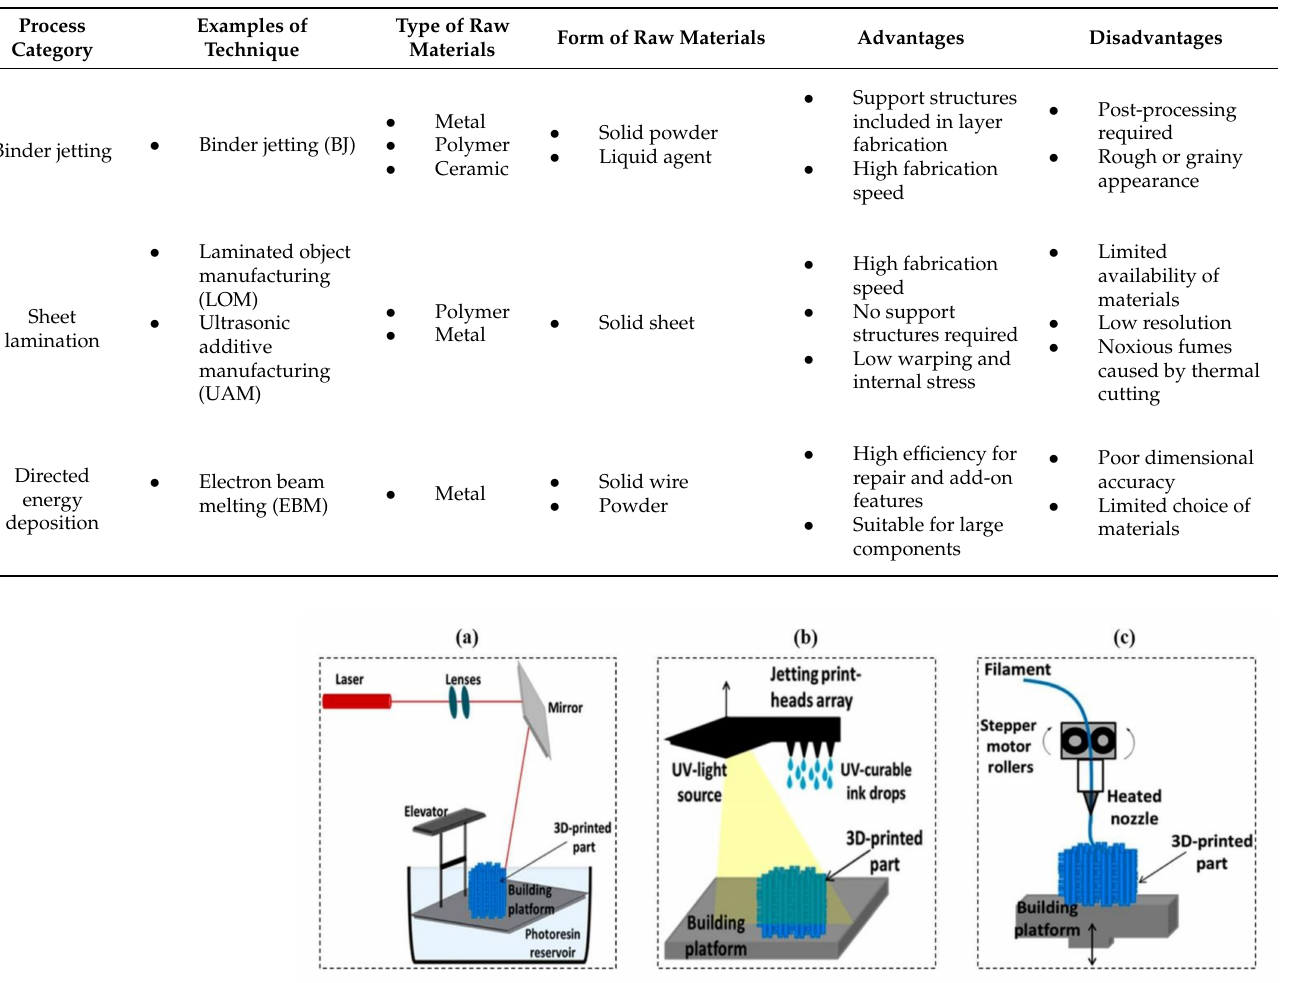
Figure 2. Diagram of common 3D printing methods: ( a ) light curing (SLA), ( b ) inkjet printing, ( c ) fused deposition printing (FDM). Reprinted with permission from Ref. [41]. Copyright 2021, Farid, M.